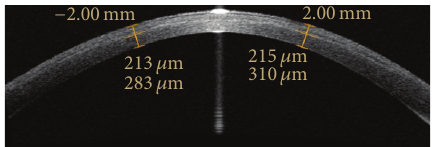
Figure 1: Optical coherence tomography images of the cornea 1 month after accelerated